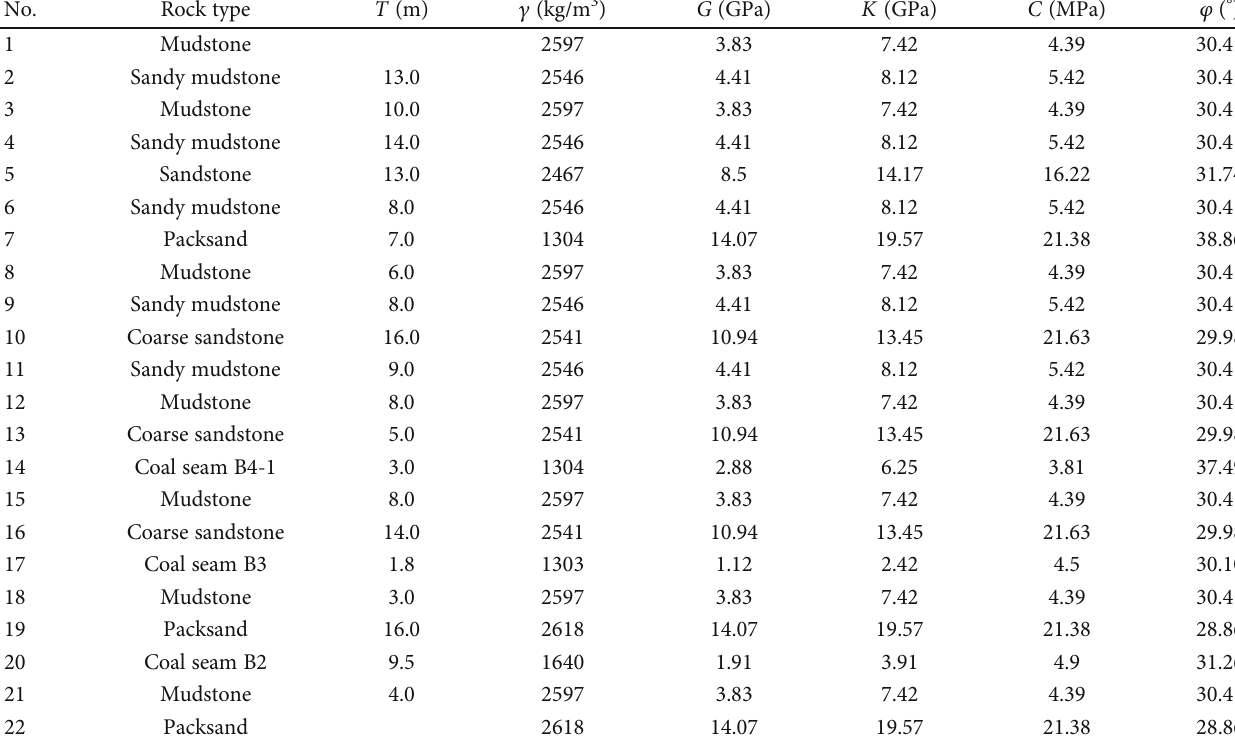
Table 2: Physical and mechanical parameters of the coal-rock